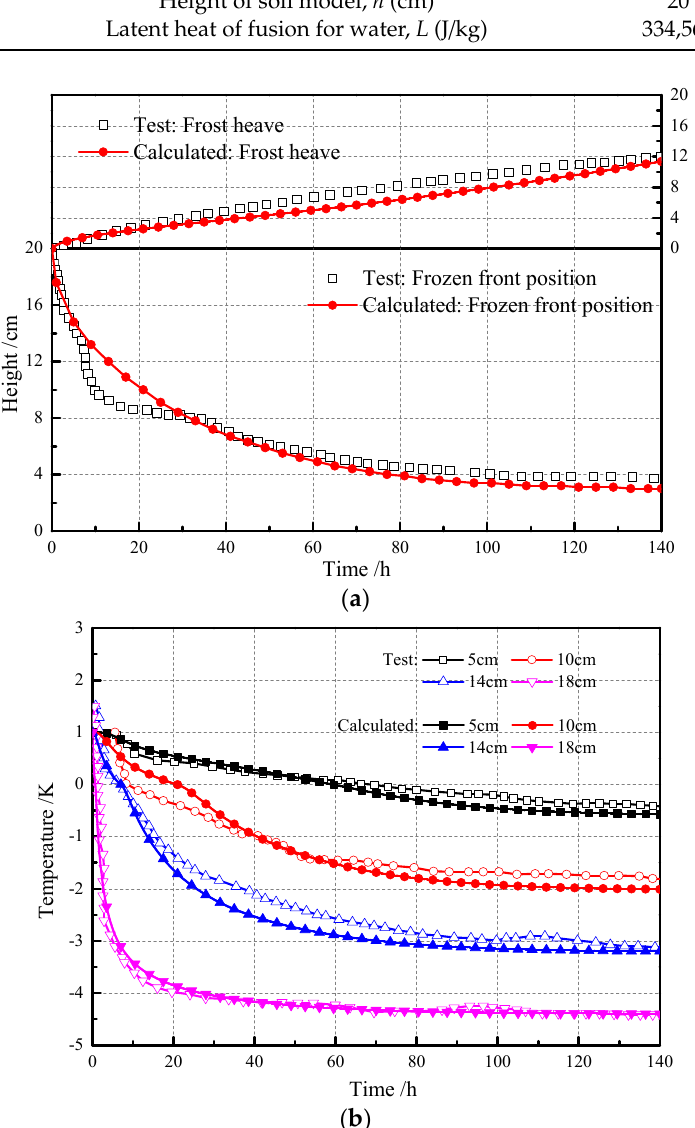
Figure 4. Comparison between simulation results and experimental data. ( a : Frost heave profiles and frozen front profiles during freezing process; b : Temperature profiles at the heights of 5, 10, 14, and 18 cm during freezing process . ).